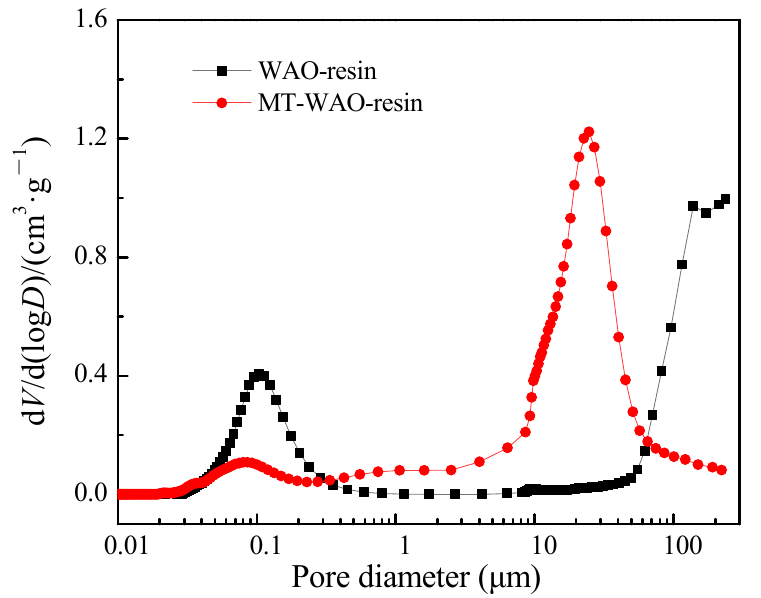
Figure 4. Differential pore volume distribution of pores with different diameters of MT-WAO resin. By comparing the pore structure of WAO resin, it is found that the pore volume of the pore size of less than 1 µ m decreases. Microwave treatment causes the pores (<1 µ m) to develop into 4.0–57.4 µ m super pores. The total porosity and internal porosity of MT-WAO resin increase slightly, making WAO resin’s pore structure more